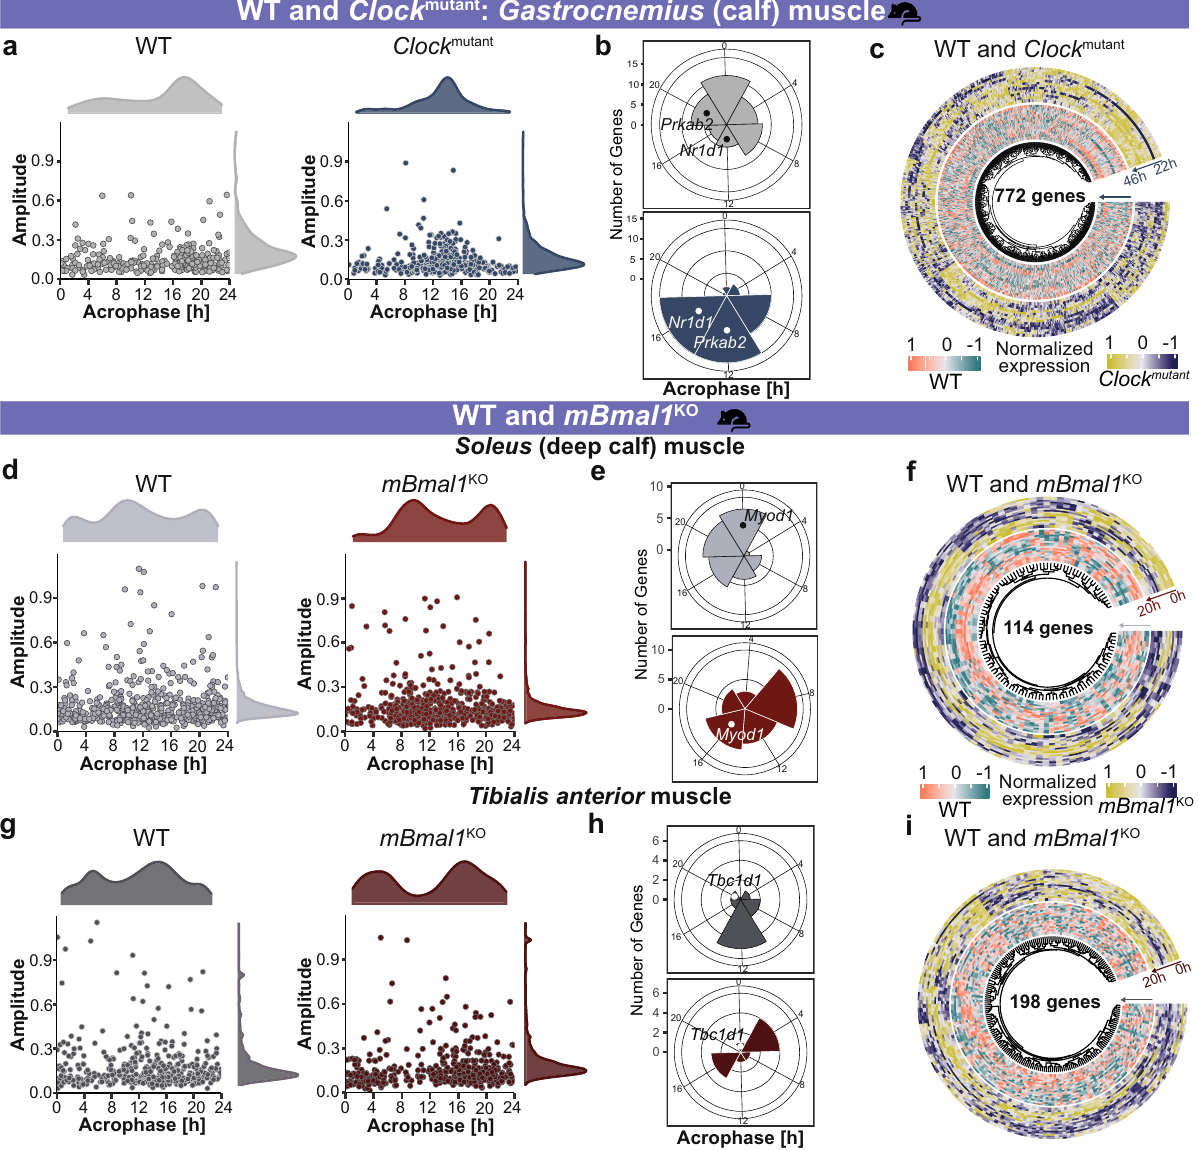
Fig. 3 Clock alterations resulted in changes among circadian properties and differential expression in mouse skeletal muscle. a Scatter plot depicts the overall distribution of ~24 h genes of interest in WT and Clock mutant mice. b Acrophase bin plot depicts the distribution of phases of differentially rhythmic genes of interest between WT and Clock mutant . c Circular heatmap plot represents the expression pro fi le of 772 differentially expressed genes of interest between WT and Clock mutant . d , g Scatter plot depicts the overall distribution of ~24 h genes of interest in Soleus and Tibialis anterior muscle of WT and mBmal1 KO mice. e , h Acrophase bin plot depicts the distribution of phases of differentially rhythmic genes of interest between WT and mBmal1 KO . f , i Circular heatmap plot represents the expression pro fi le of 114 (in Soleus ) and 198 (in Tibialis anterior ) differentially expressed genes of interest between WT and mBmal1 KO like 2 ( Ndufa4l2 ), and Fatty acid binding protein 3 ( Fabp3 ). Atf4 acts as a regulator of metabolic and redox processes while Fgf2 is important for cytokine activity. Ndufa4l2 is an integral part of mitochondrial respiratory chain and Fabp3 participates in intra- cellular metabolism. The alteration in core-clock components ( Bmal1 or Clock ) in mice resulted in a phase shift among genes of interest when compared to their control conditions (Fig. 3b, e, h). A total of 87 genes showed a phase shift (>4 h; q < 0.05) in either mBmal1 KO or in Clock mutant vs. their controls (Fig. 3b, e, h). The cycle progression showed phase shift (>4 h; q < 0.05) in both core-clock genes Nr1d2, Arntl and metabolism associated gene, Tibialis anterior muscle of mBmal1 KO (Fig. 3h) and Clock mutant mice Protein kinase AMP-activated non-catalytic subunit beta 2 ( Prkab2 ) datasets. Cry2 signi fi cantly lost rhythmicity ( q < 0.05) due to showed a phase shift (>4 h; q < 0.05) in Clock mutant vs. WT tissue mBmal1 KO , while Myod1 and other clock-related genes ( Nr1d1 ,